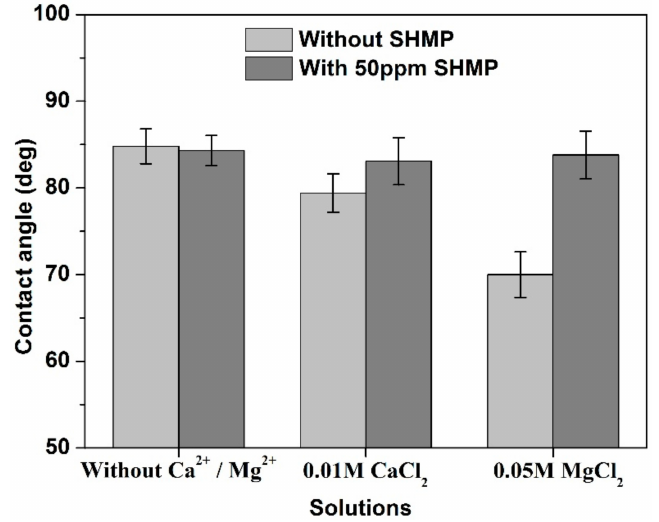
Figure 8. Contact angle of MoS 2 treated in various solutions at pH